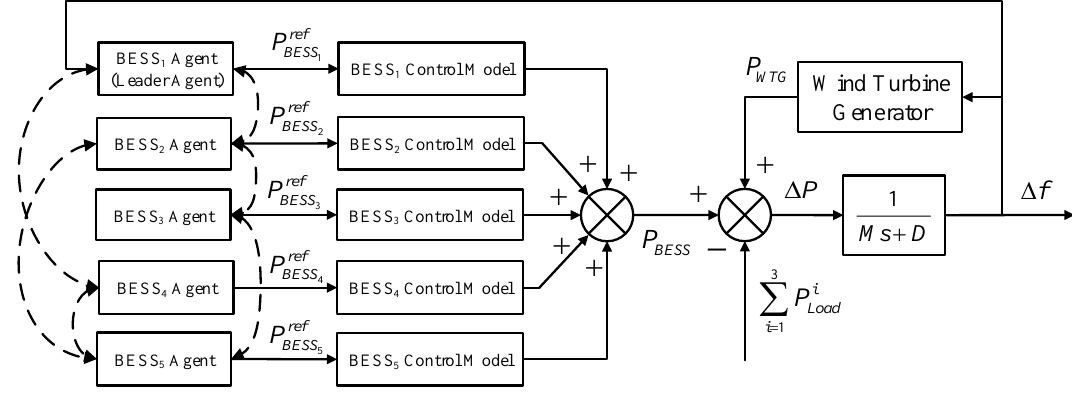
Figure 10. The proposed control strategy of the microgrid.